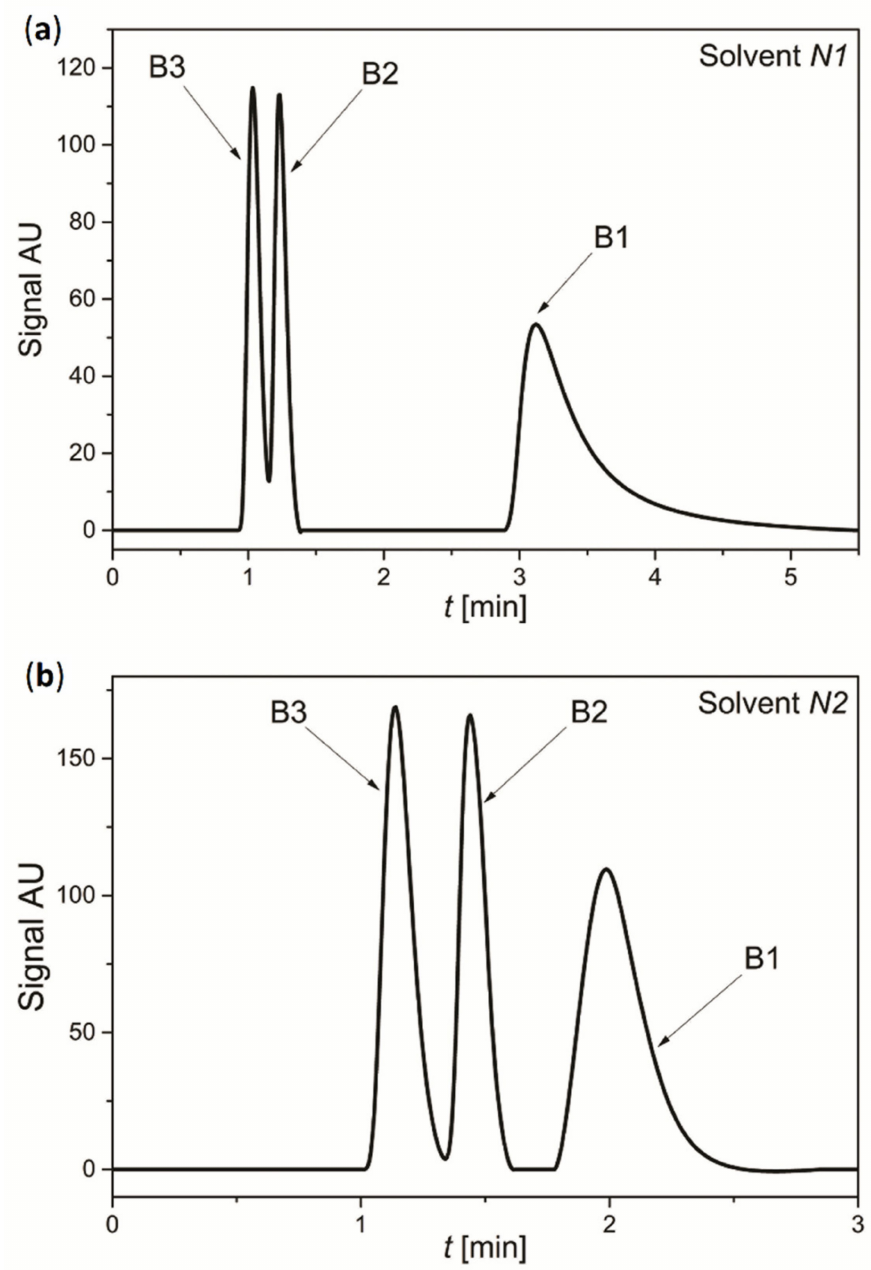
Figure 16. Separation of vitamin mixture obtained using column N and solvent: ( a ) N 1 and ( b ) N 2 as mobile